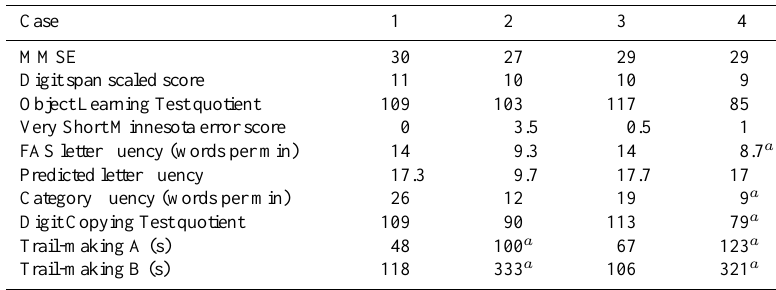
Table 2 Neuropsychological test